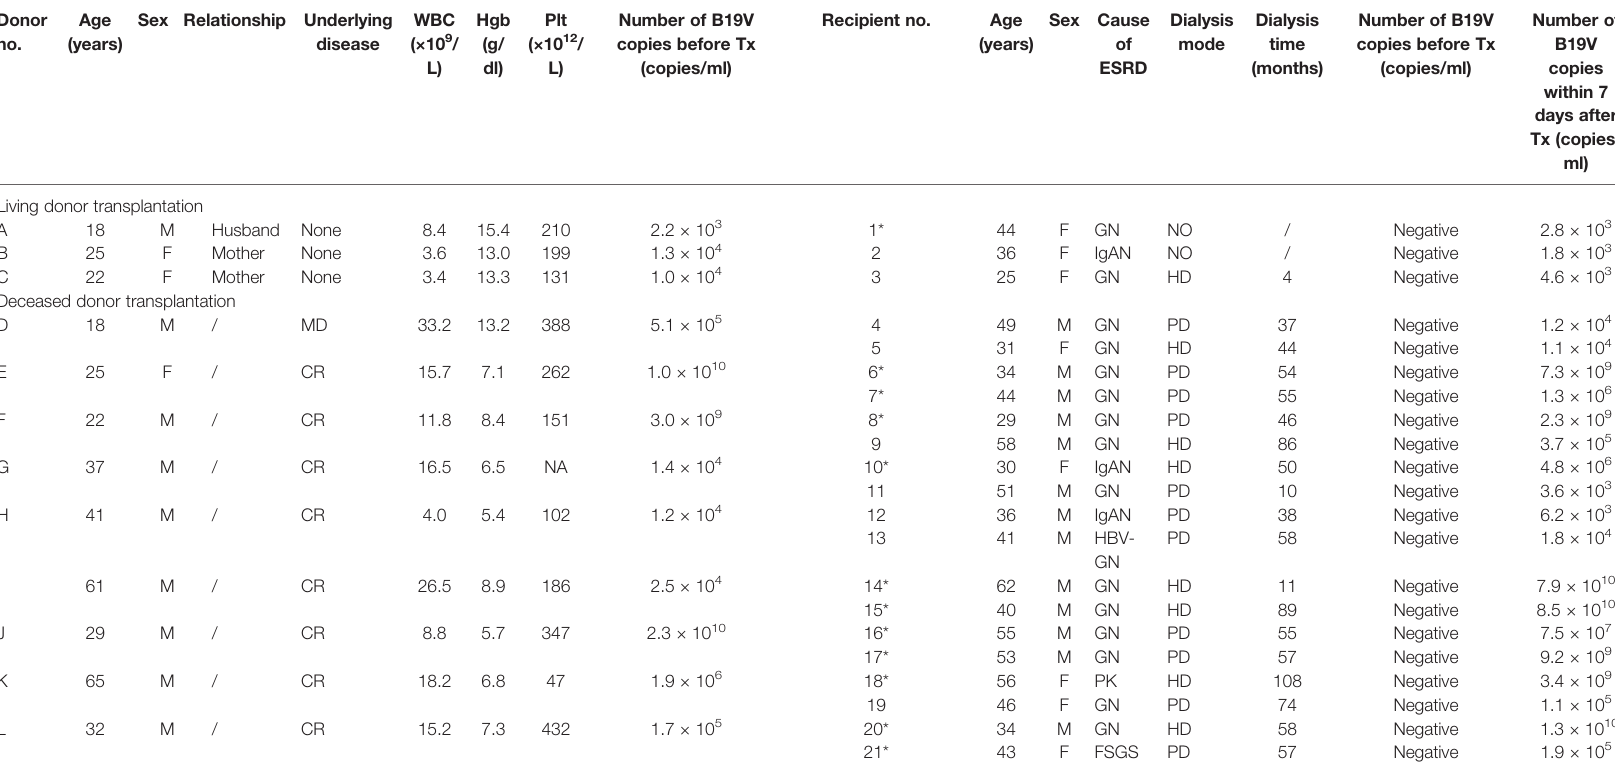
TABLE 1 | Clinical characteristics of donor-derived B19V infection in living or deceased donors and their corresponding kidney transplantation recipients. Donor